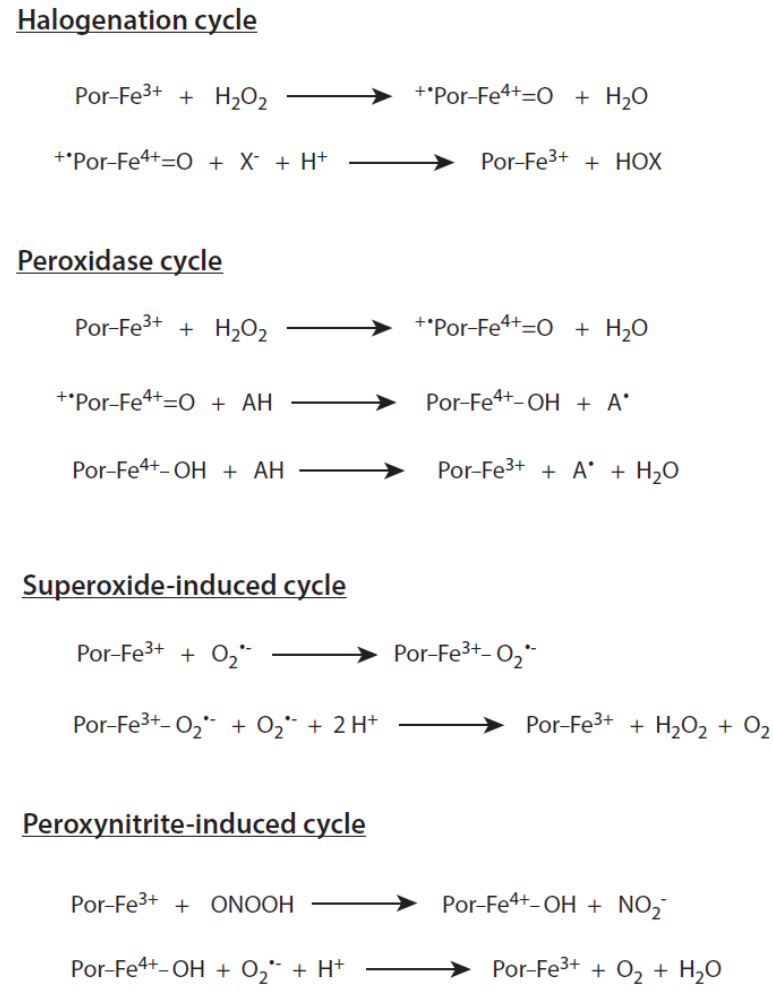
Figure 1. Major catalytic cycles of myeloperoxidase. Further explanations are given in the text. The heme states of MPO are denominated as in Table 1. X − stands for Cl − , Br − , I − , and SCN − . HOX is the corresponding (pseudo)hypohalous acid. AH is an oxidizable substrate, and A • the resulting substrate radical.